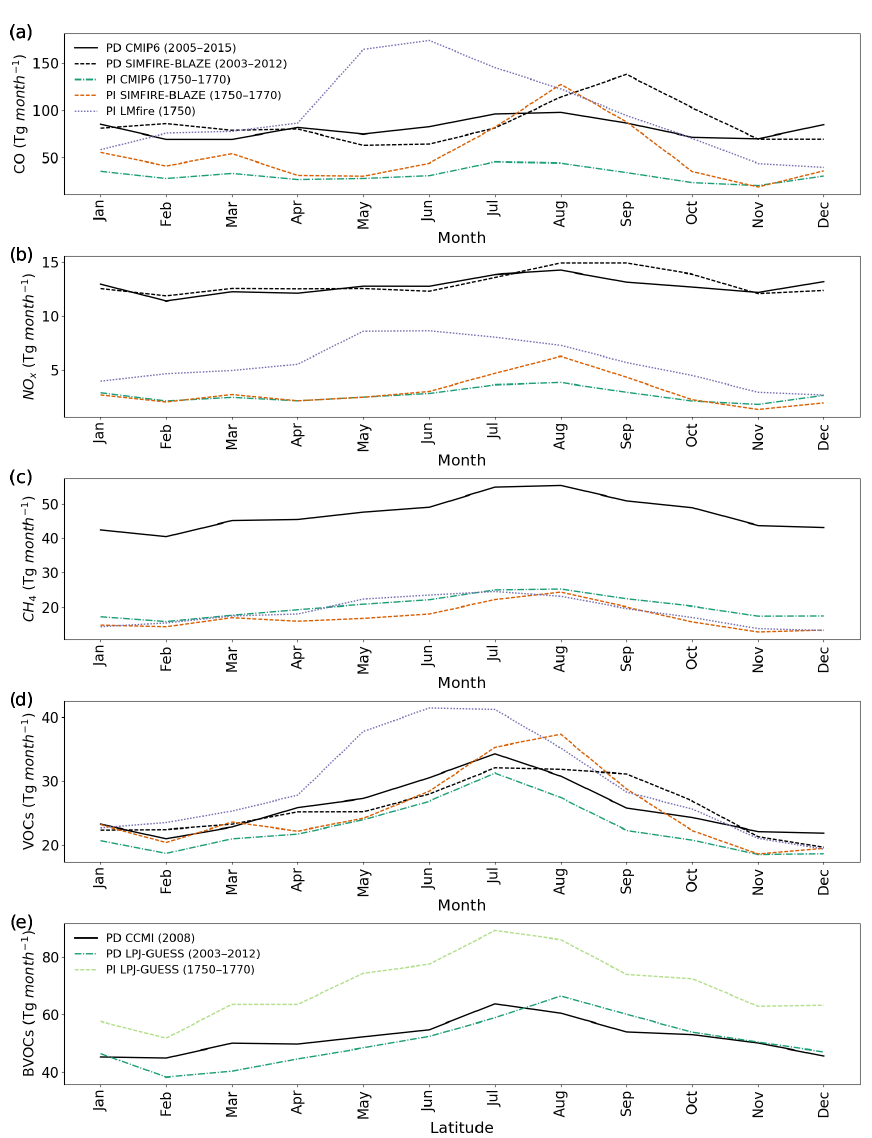
Figure 3. Total monthly emissions (Tg per month) of (a) CO, (b) NO x , (c) CH 4 , (d) VOCs and BVOCs (e) for PD CMIP6 (solid black line), PD SIMFIRE-BLAZE (dashed black), PI CMIP6 (dashed green), PI SIMFIRE-BLAZE (dotted orange), PI LMfire (dashed purple), PD LPJ-GUESS (dashed dark green) and PI LPJ-GUESS (dotted light green). The legend in panel (a) also applies to panels (b) , (c) and (d)